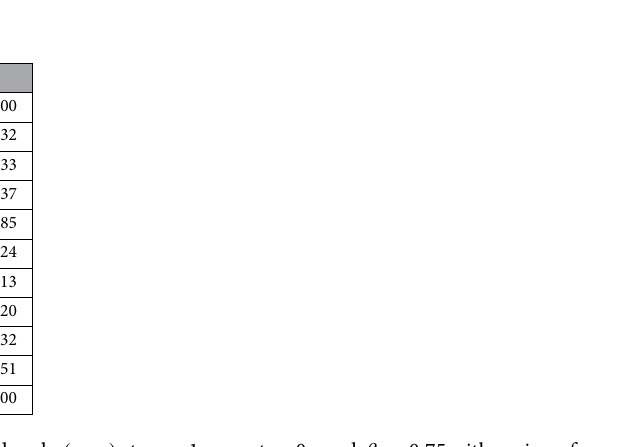
Table 4. Fuzzy solution of v ( x , α) , mid and u ( x , α) at m = 1, α -cut = 0, and β = 0.75 with varing of x .